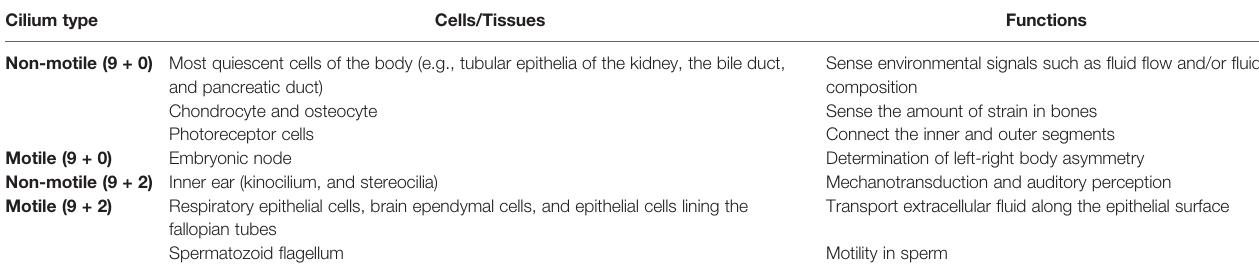
TABLE 1 | Main categories of cilia in humans (10 – 15). Cells/Tissues